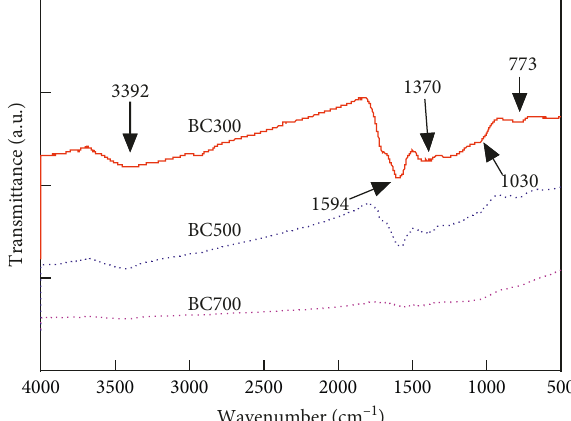
Figure 3: Fourier-transform infrared (FTIR) transmission spectra of BC300, BC500, and